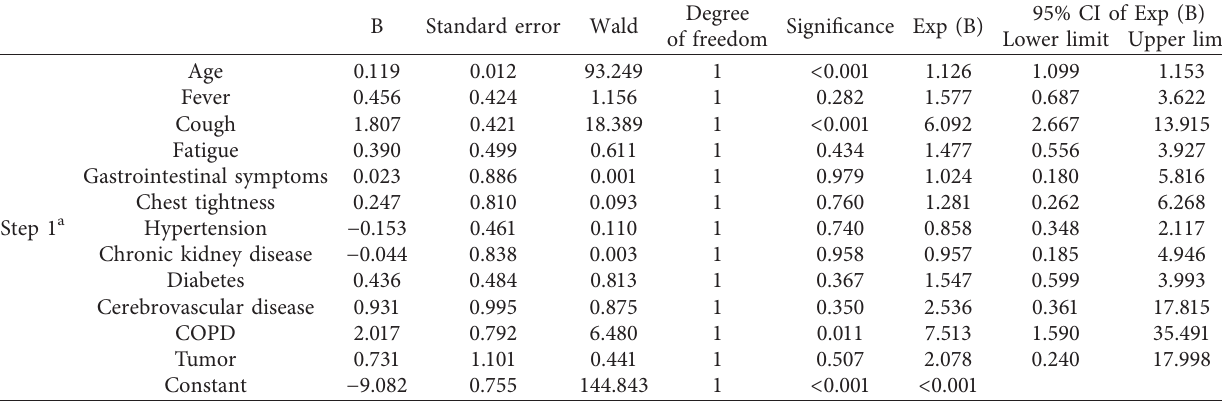
Table 7: Influential factors of aggravation to severe COVID-19 after removing complications.